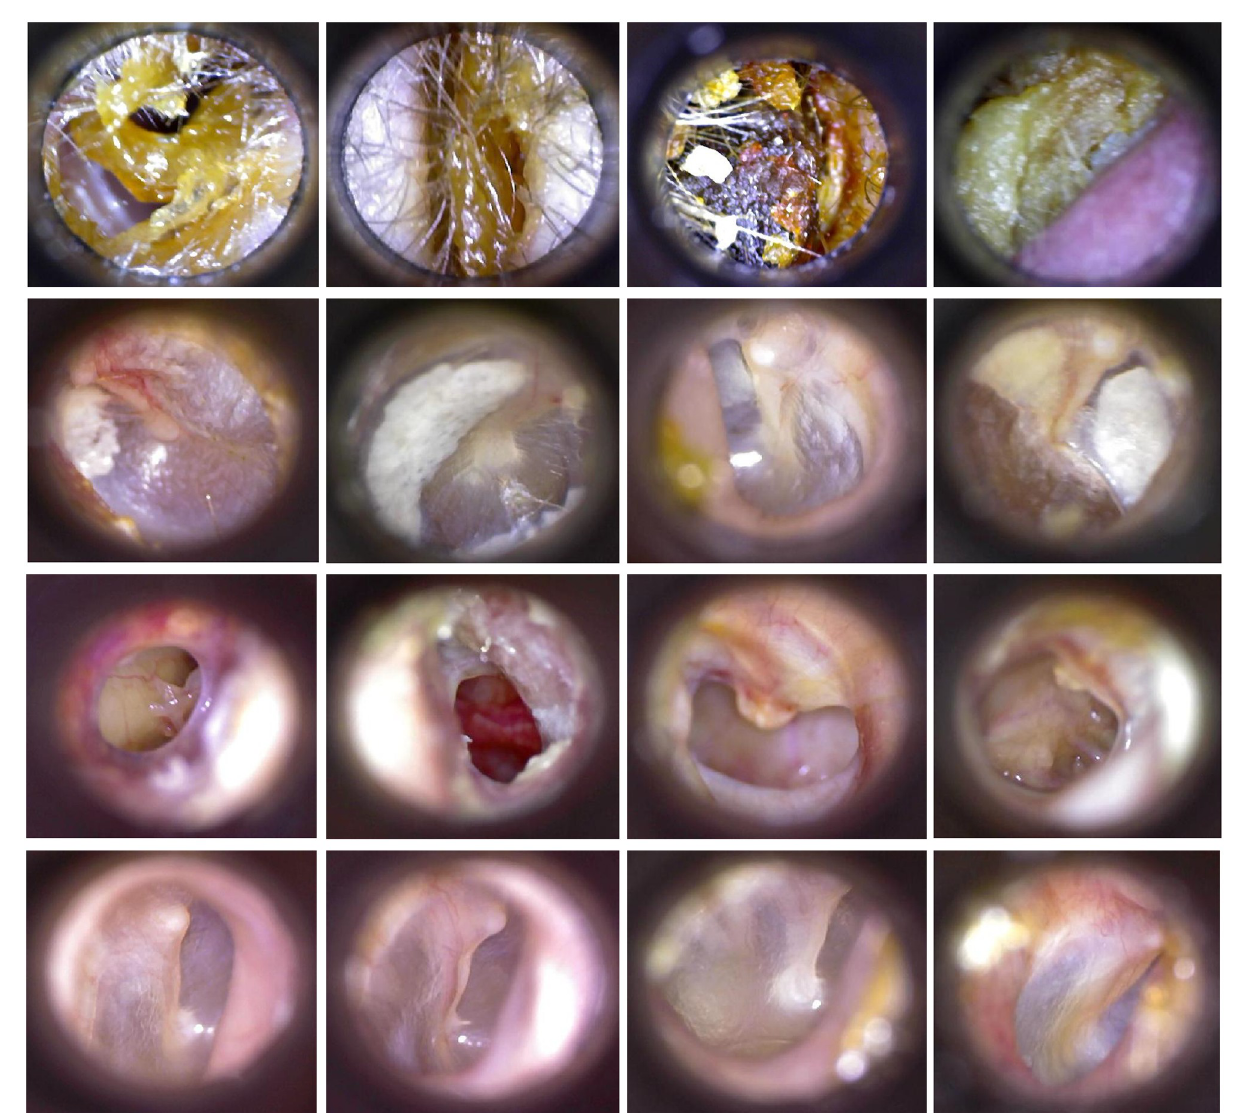
Fig 3. Ear imagery database per class. By rows, from top to bottom: earwax cases, myringoesclerosis cases, chronic otitis media cases and normal cases.